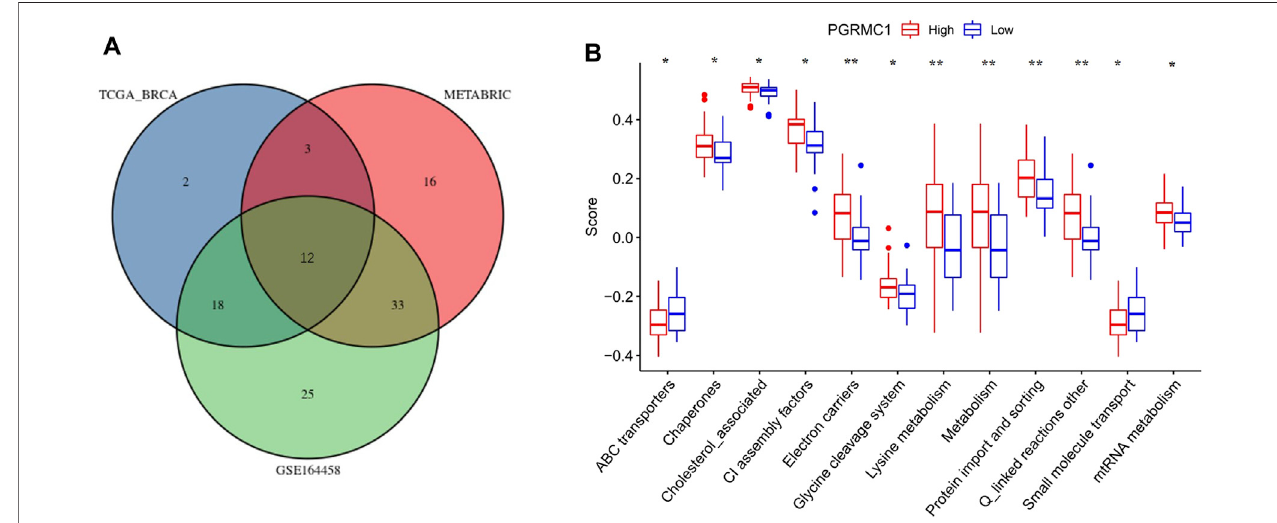
FIGURE 5 | (A) Venn-diagram showing the result of GSVA analysis. (B) GSVA scores of the 12 mitochondrial pathways between high- (25%) and low-PGRMC1 (25%) expression samples in TNBC of TCGA-BRCA.